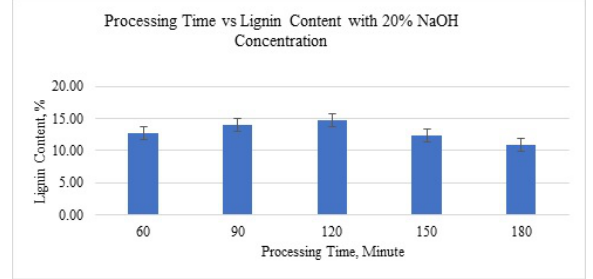
Fig. 4. The Correlation of NaOH Solution Concentration with Lignin Contents in OPEFB Delignification Process Fig. 3. The Correlation of NaOH Concentration as Alkali with Processing Time of 120 minutes Solvent in Delignification Process with Yield of Crude Extract Powder at Variation of Processing Time of 120 Minutes